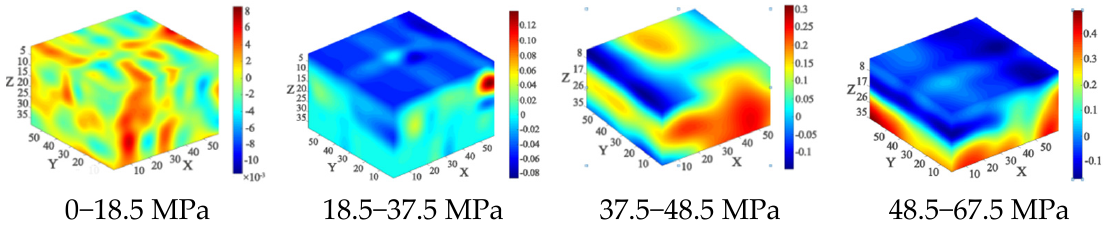
Figure 17. Evolution process of volume strain nephogram.